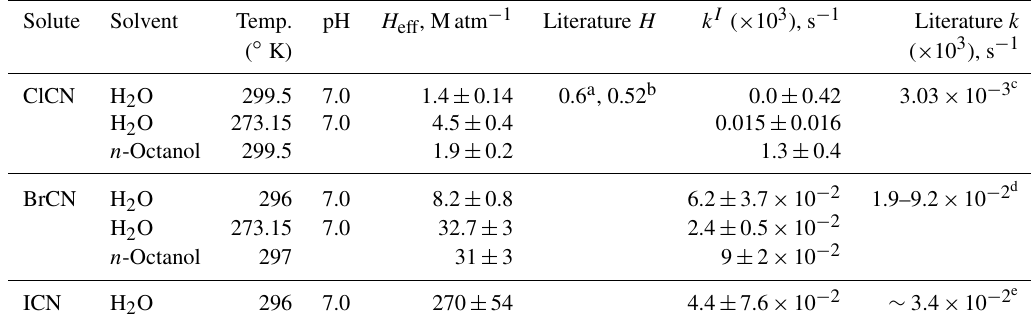
Table 2. Summary of solubility and loss rate measurements of XCN compounds. Solute Solvent